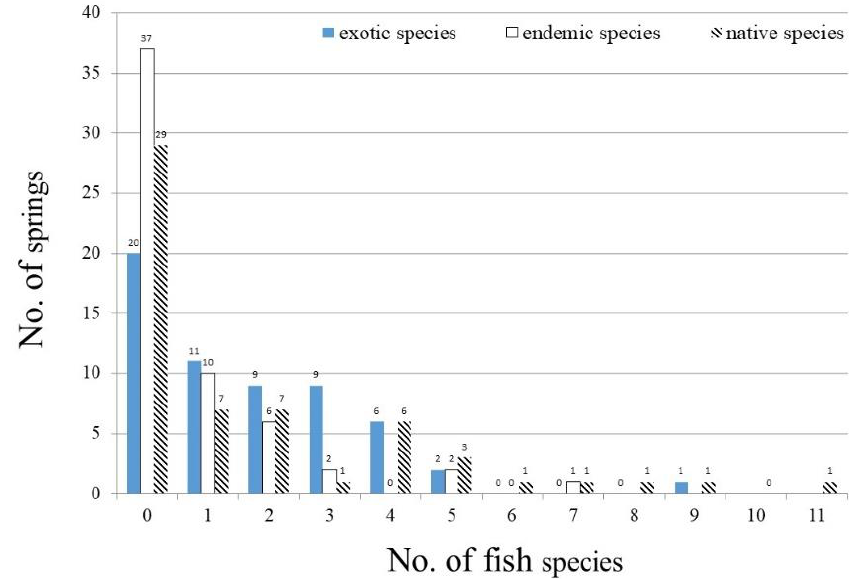
Figure 3. Occurrence frequency of 58 sampled springs for exotic, endemic, and native fish species.